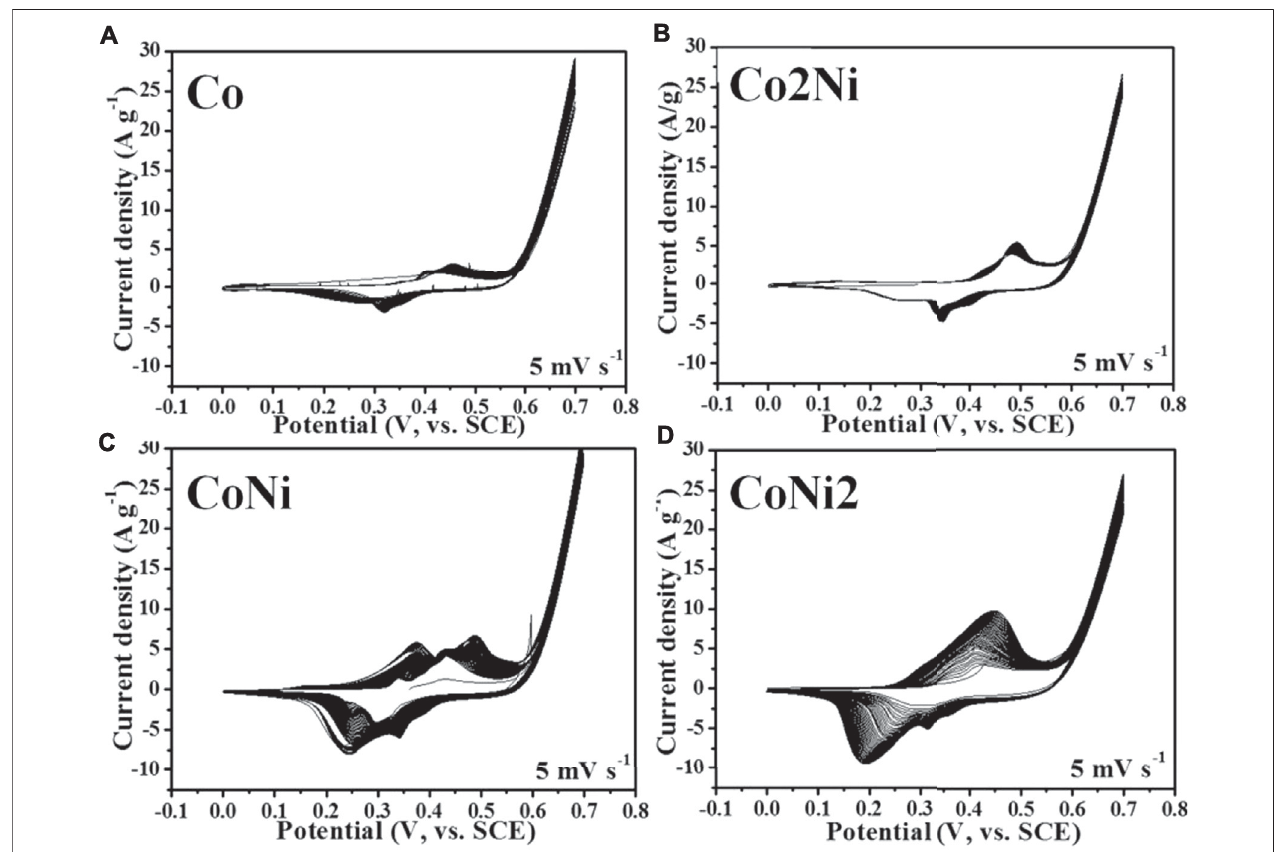
FIGURE4| Initial50cyclesofCVcycliccurvesofCo/Nibasiccarbonatenanowire/CNTpapercompositeelectrodeswithdifferentCo/Niratiosat5 mV s − 1 :Co (A) ; Co2Ni (B) ; CoNi (C) ; CoNi2 (D)